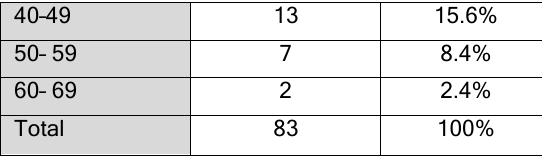
Table (2)distribution of Age Mechanism of trauma included shell injury (54.2%), bullet (37.4%), and stab wound (8.4%) (Table 3).